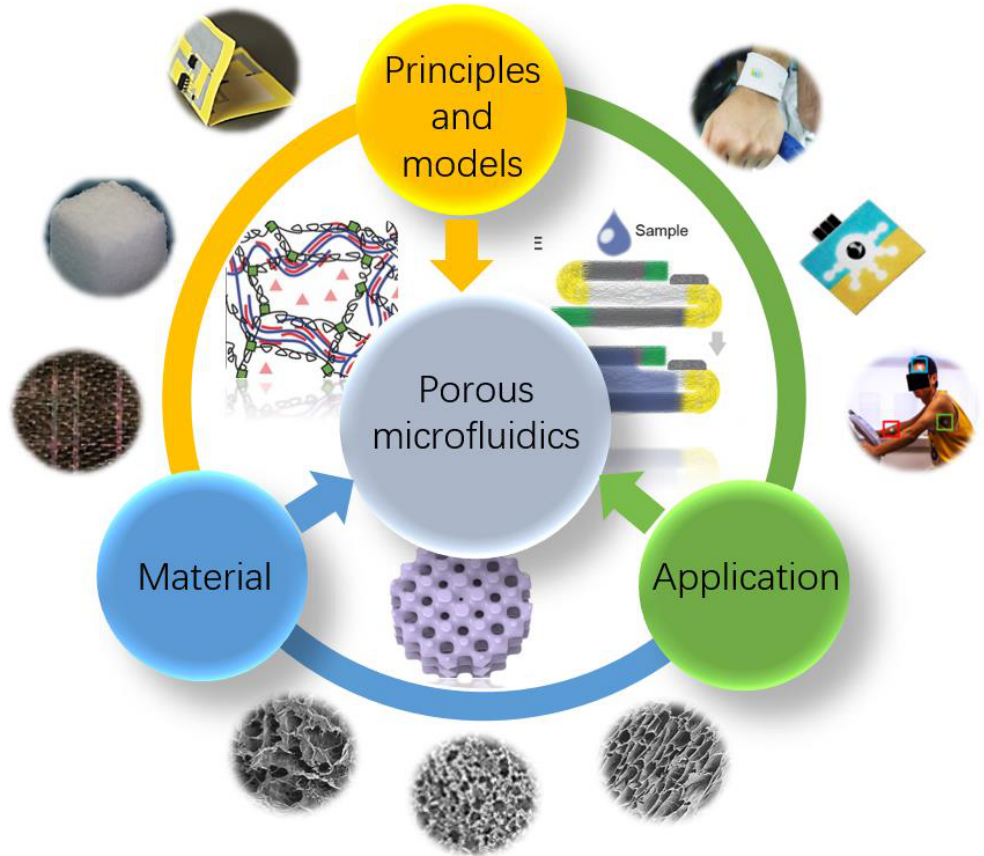
Figure 1. Illustration of the structure of this review. With the help of advanced material and theoretical modeling, the constantly advancing applications of porous microfluidic device for biomedical diagnosis. Reproduced with permission. Ref. [31] Copyright 2012, Sensors and Actuators B: Chemical. Reproduced with permission. Ref. [32] Copyright 2017, Advanced Functional Materials.